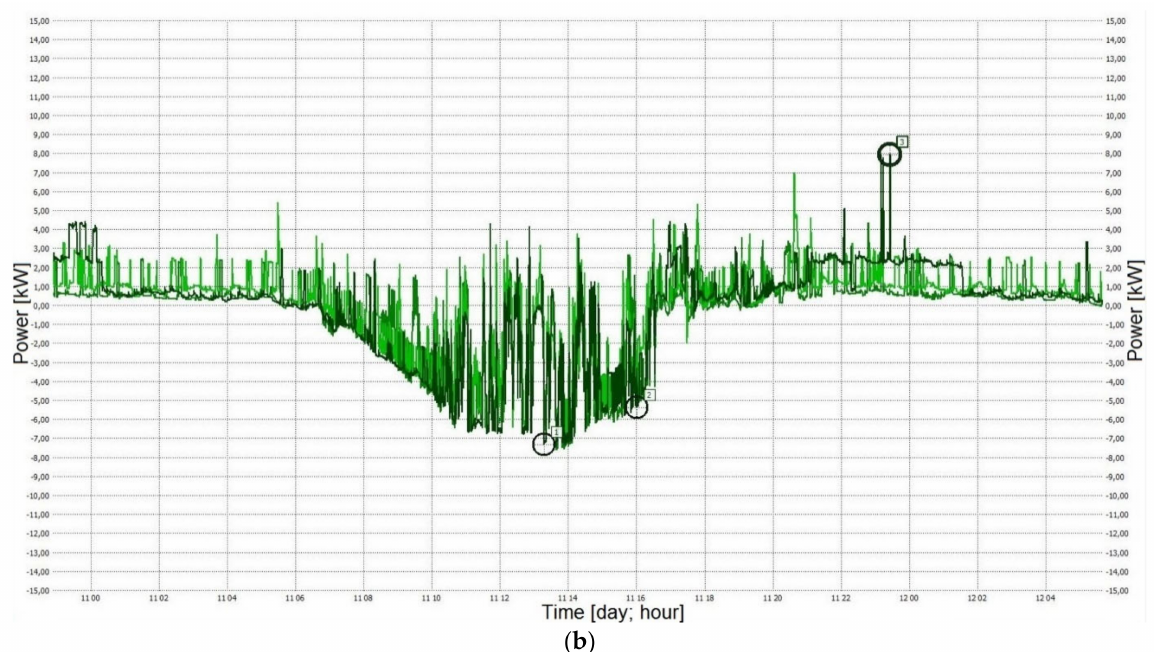
Figure 7. Voltage and active power variations in node 105 (period: 11 June 2021, hour 0:00 a.m. −